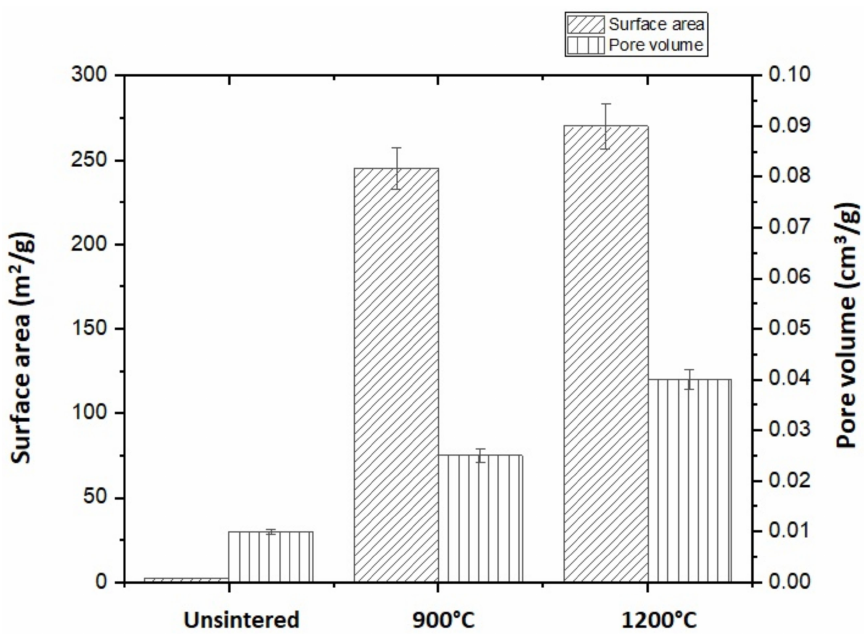
Figure 4. Surface area and pore volume of kaolin geopolymer samples versus sintering